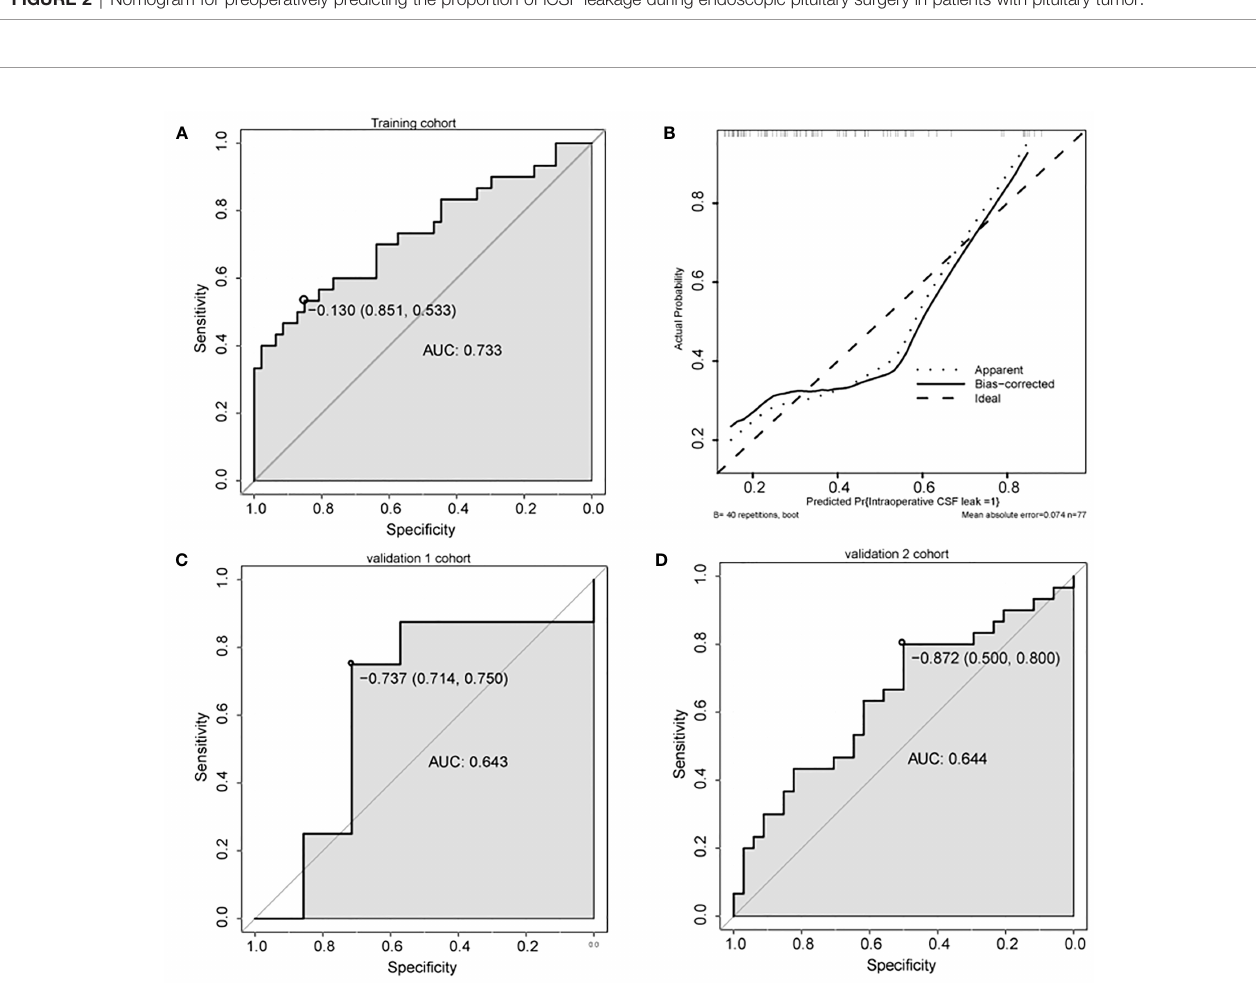
FIGURE 3 | Predictive performance of the nomogram. (A, C, D) ROC analysis of nomogram in training cohort (A) , validation cohort 1 (C) , and validation cohort 2 (D) . (B) Calibration plots of the nomogram. AUC, area under the